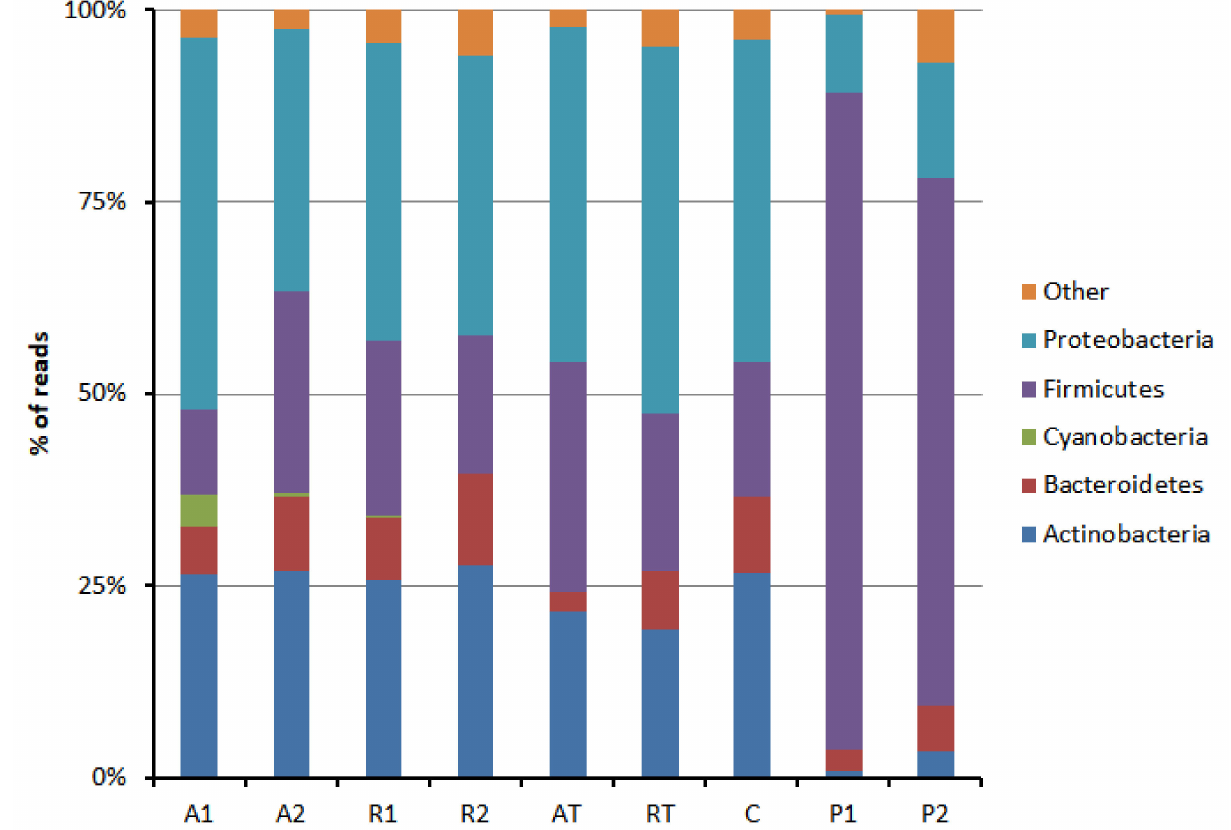
Figure 1. Phylum-wise distribution pattern of bacterial population in bee bread and bee pollen samples (A1 and A2 = bee breads collected from two colonies fed with oak pollen patty; R1 and R2 = bee breads collected from two colonies fed with rapeseed pollen patty; AT = bee bread collected from colony fed on oak pollen patty with restricted inflow of pollen from outside; RT = bee bread collected from colony fed on rapeseed pollen patty with restricted inflow of pollen from outside; P1 and P2 = bee pollen collected from bee hives equipped with pollen trap; C = bee bread collected from control